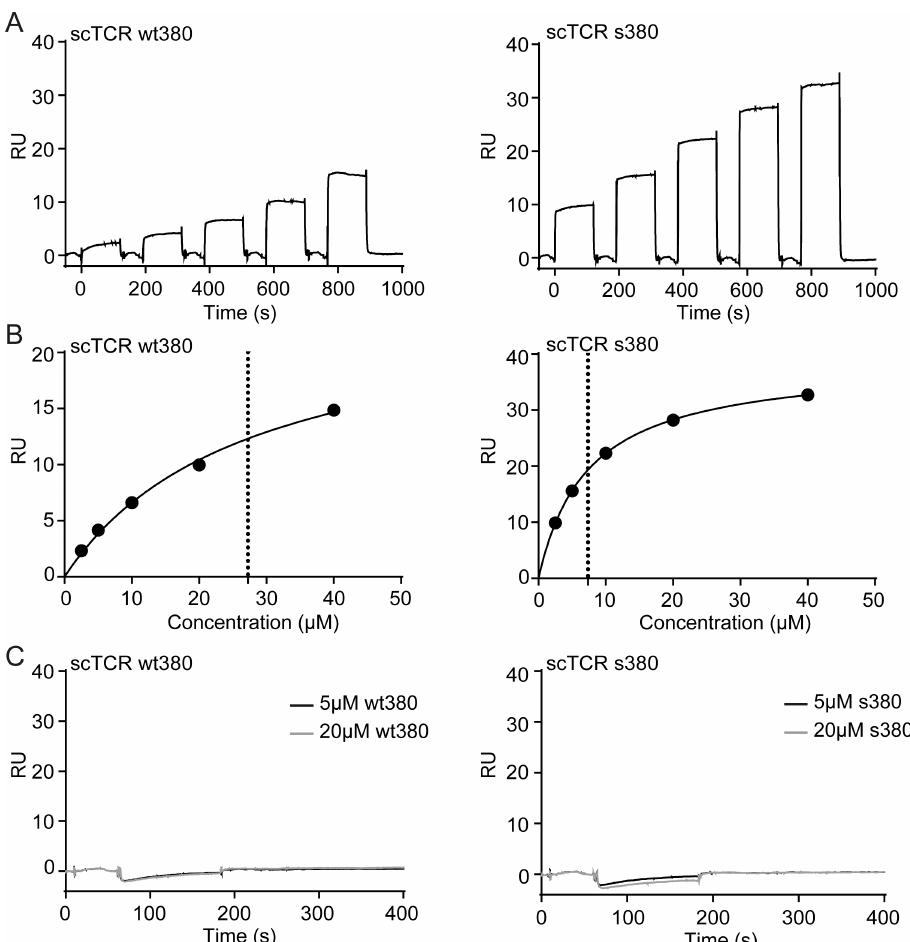
Fig 5. SPR binding characteristics of the scTCRs. (A) Biotinylated pMHC was captured on neutravidin-coated sensor chips followed by injection of a 2-fold dilution series from 40 μ M of scTCR. Representative sensograms of scTCR wt380 and scTCR s380 binding to HLA-DQ2.5:DQ2.5-glia-a1a ( n = 1–3). (B) The equilibrium response was plotted against concentration to derive the equilibrium dissociation constant (K D ) of the scTCRs wt380 and s380. Dotted line indicates the K D based on fitting the response to saturation. The K D values are summarized in Table 3. (C) Biotinylated HLA-DQ2.5:CLIP2 was captured on neutravidin-coated sensor chips followed by injection of 5 μ M or 20 μ M of scTCRs. Representative sensograms of scTCR wt380 and scTCR s380 are shown ( n = 1–3).